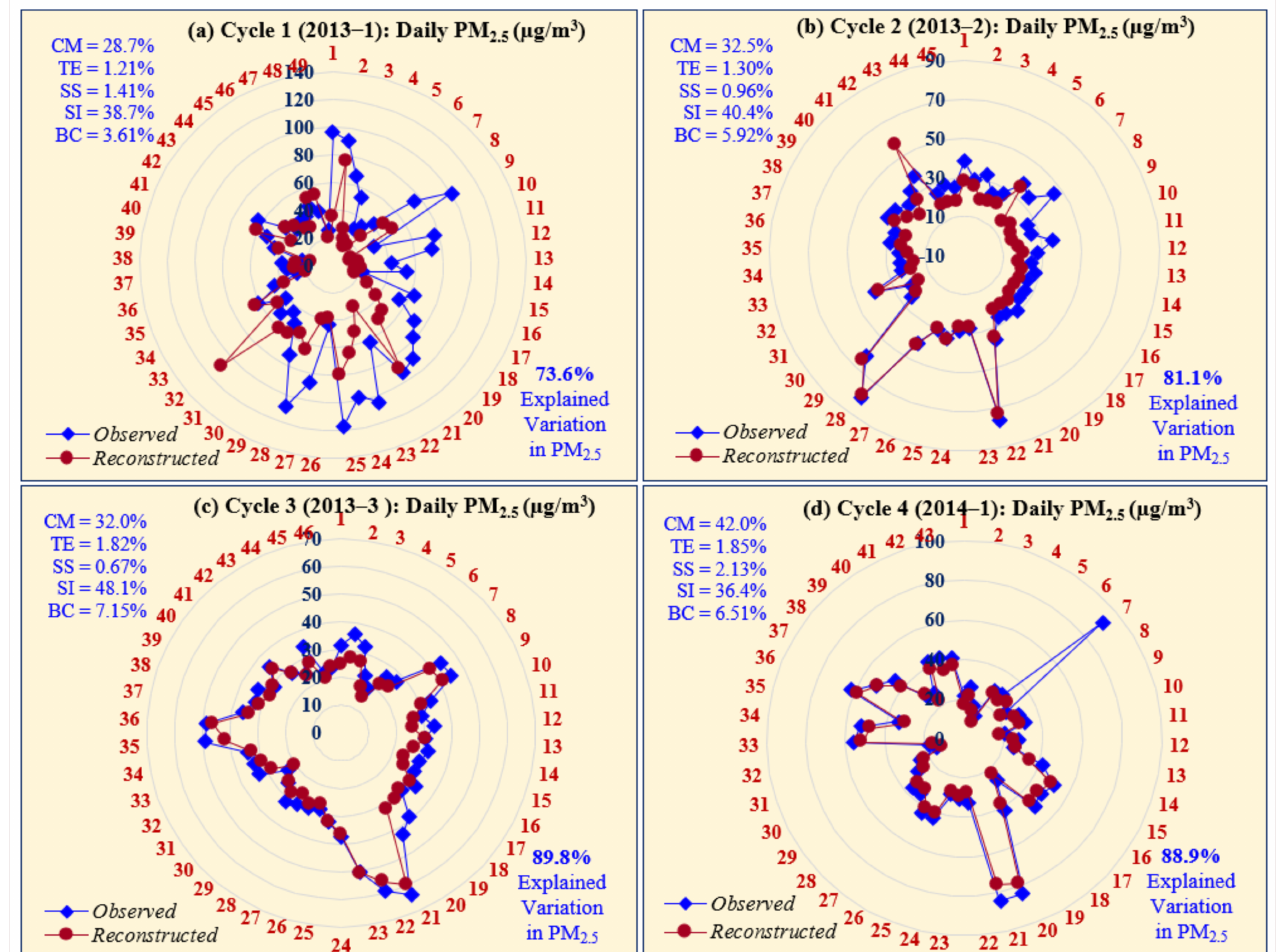
Figure 4. Variations in the observed and reconstructed PM 2.5 per cycle averaged sampling sites: cycle 1—( a ), cycle 2—( b ), cycle 3—( c ), cycle 4—( d ) The relative proportions of daily PM 2.5 explained